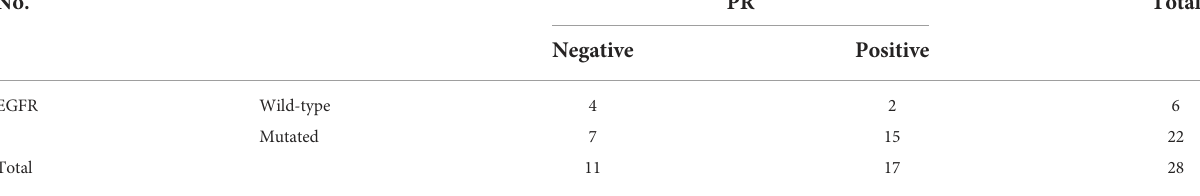
TABLE 2B Correlation of EGFR mutation and PR status of breast cancer. No. PR Total Negative Positive